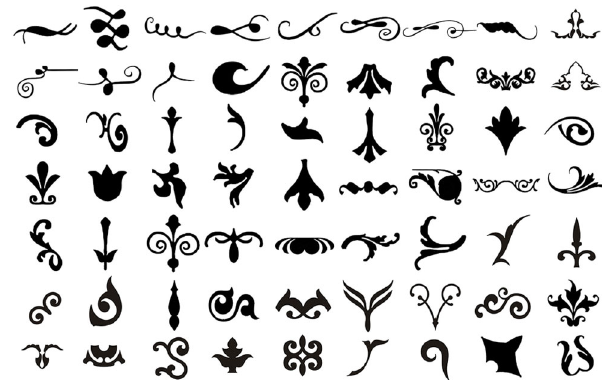
Fig. 8 Part of the library of ornamental